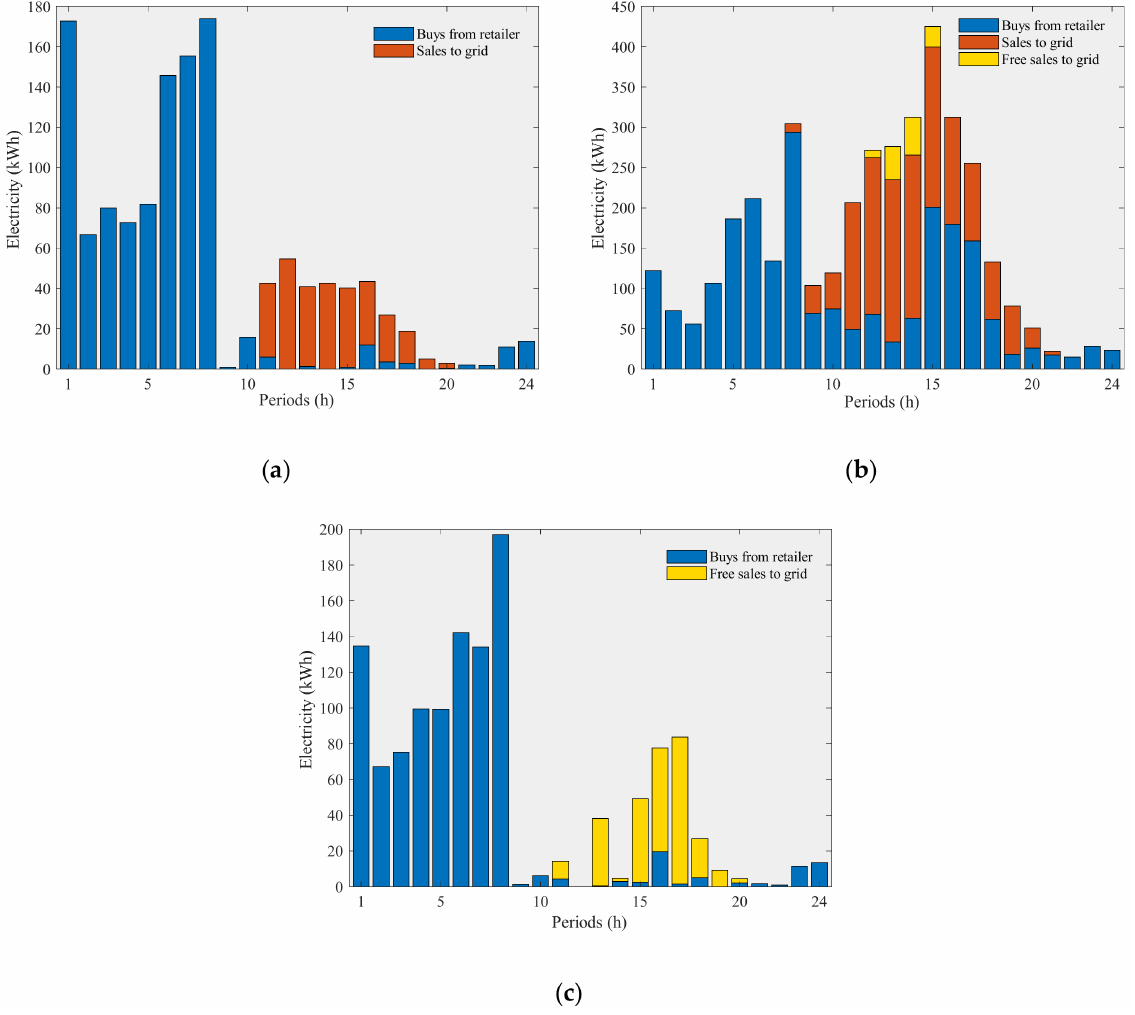
Figure 9. Electricity transactions without wholesale participation, ( a ) Scen1-CS1, ( b ) Scen1-CS2, and ( c )